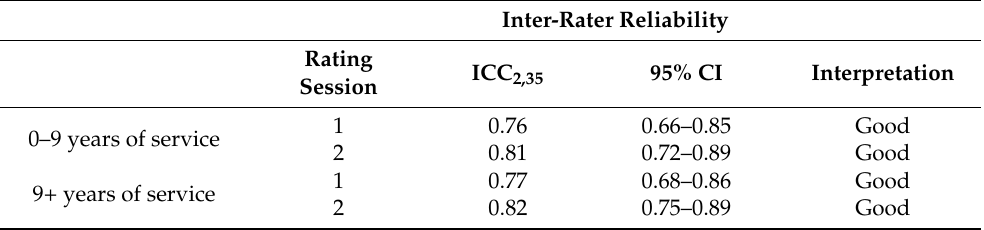
Table 2. Inter-rater reliability of all screening tests for both rating sessions based on years worked with the fire service. ICC = Intraclass correlation coefficients, CI = Confidence interval.